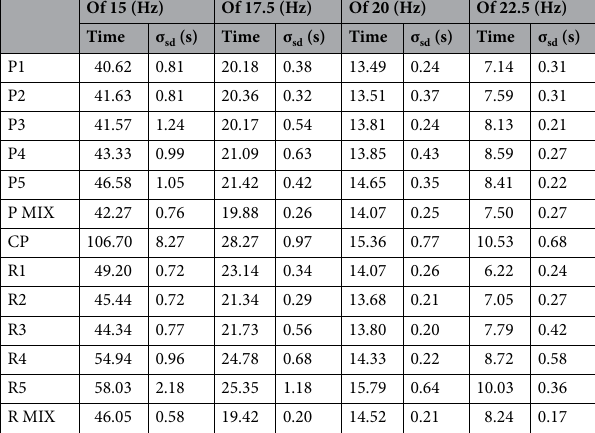
Table 7. Feed time depending on the oscillation frequency.